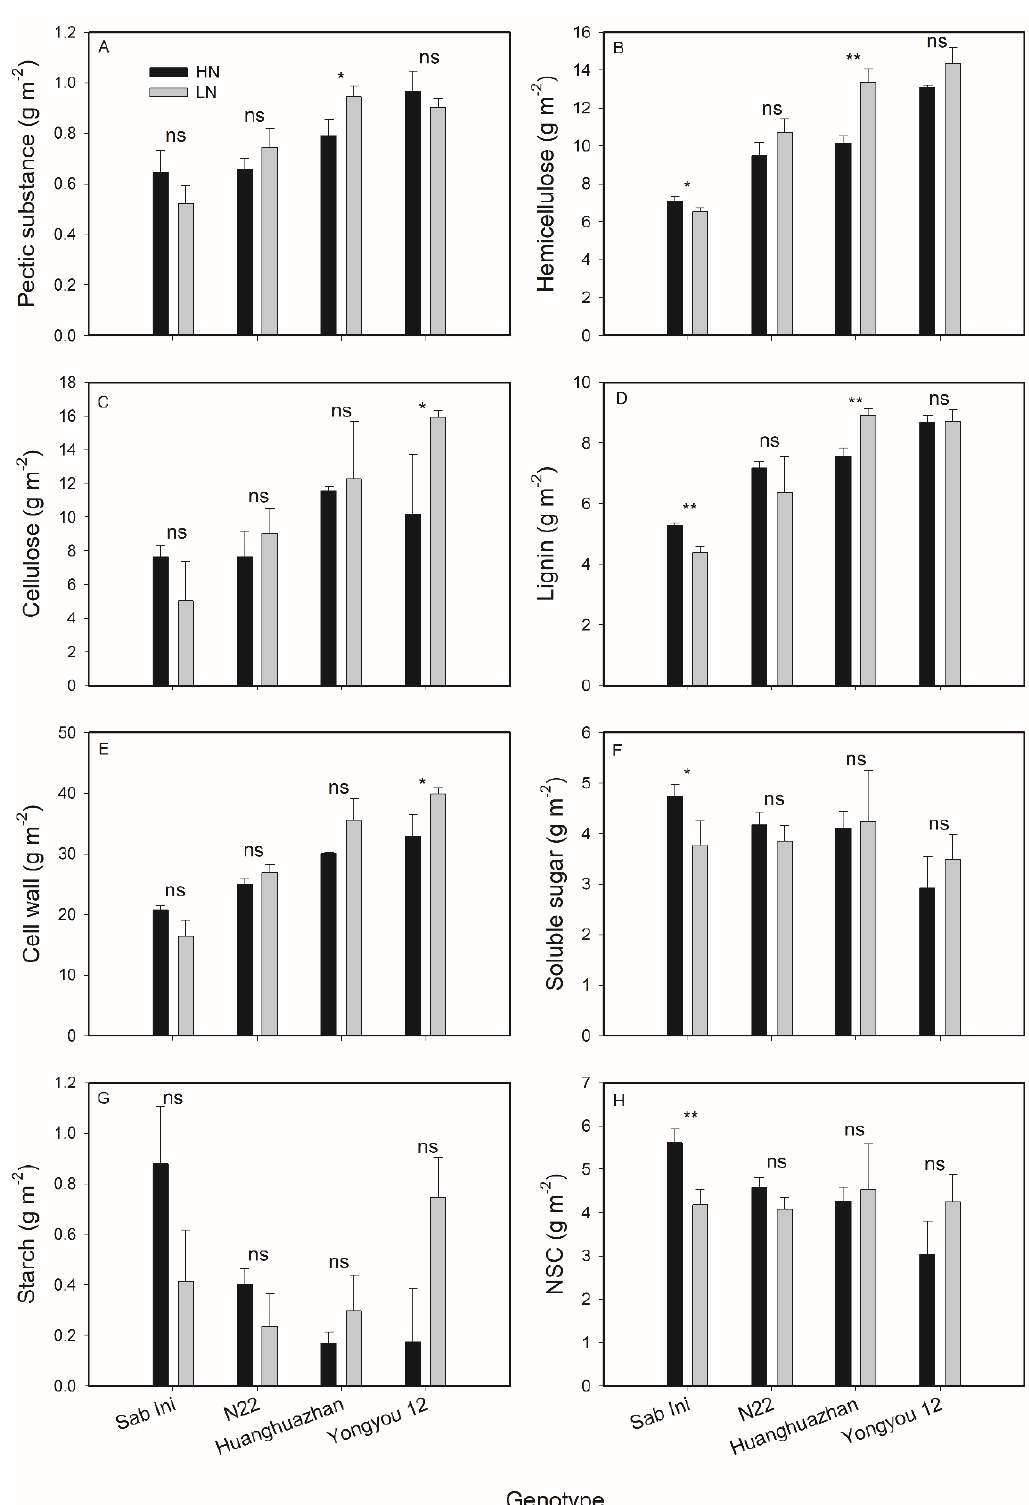
Figure 5. Variations in area-based pectic substances content ( A ), hemicellulose content ( B ), cellulose content ( C ), lignin content ( D ), cell wall content ( E ), soluble sugar content ( F ), starch content ( G ) and non-structural carbohydrates (NSC) content ( H ) in the flag leaves of the four rice genotypes between high (HN) and low (LN) nitrogen supply. Parameters were compared between HN and LN for each genotype based on the least significant difference (LSD) test at the 0.05 probability level. *, p < 0.05; **, p < 0.01; ns, non-significant.